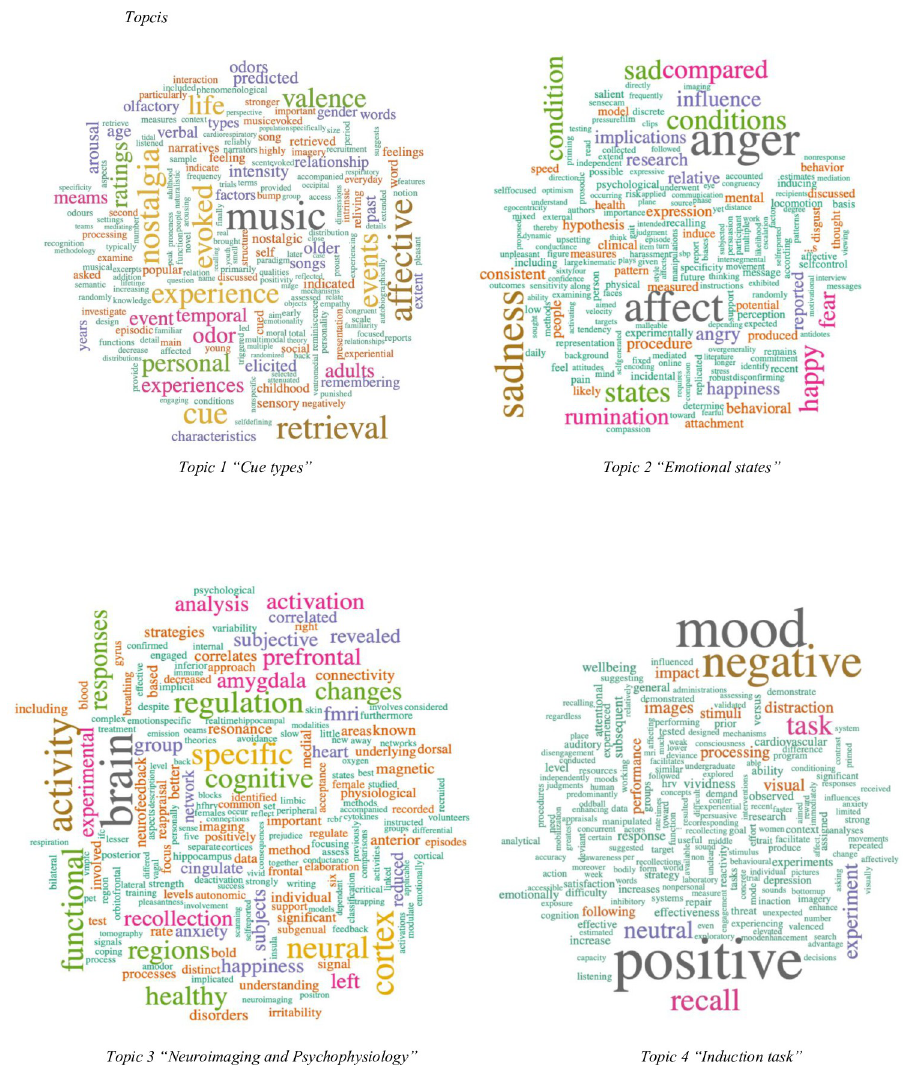
Fig 6. Topics. Topic 1 "Cue types". Topic 2 "Emotional states". Topic 3 "Neuroimaging and Psychophysiology". Topic 4 "Induction